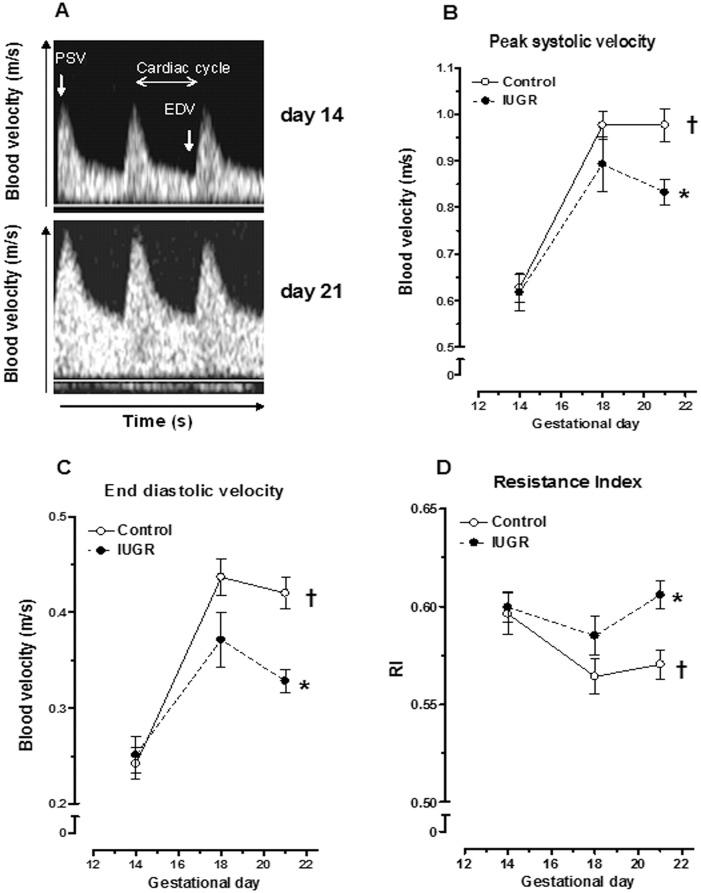
Uteroplacental circulation in control and IUGR pregnant rats.(A) Doppler flow velocity waveforms obtained in the uterine artery of a control rat at day 14 and 21 of gestation. (B) Peak systolic velocity, (C) end diastolic velocity and (D) resistance index in the uterine artery. Results are expressed as means ± SEM from 8 animals/group. † P<0.05, two-way ANOVA, effect of gestational day; * P<0.05 vs. control pregnant rat, Bonferroni post test. PSV: peak systolic velocity; EDV, end diastolic velocity; RI, resistance index.